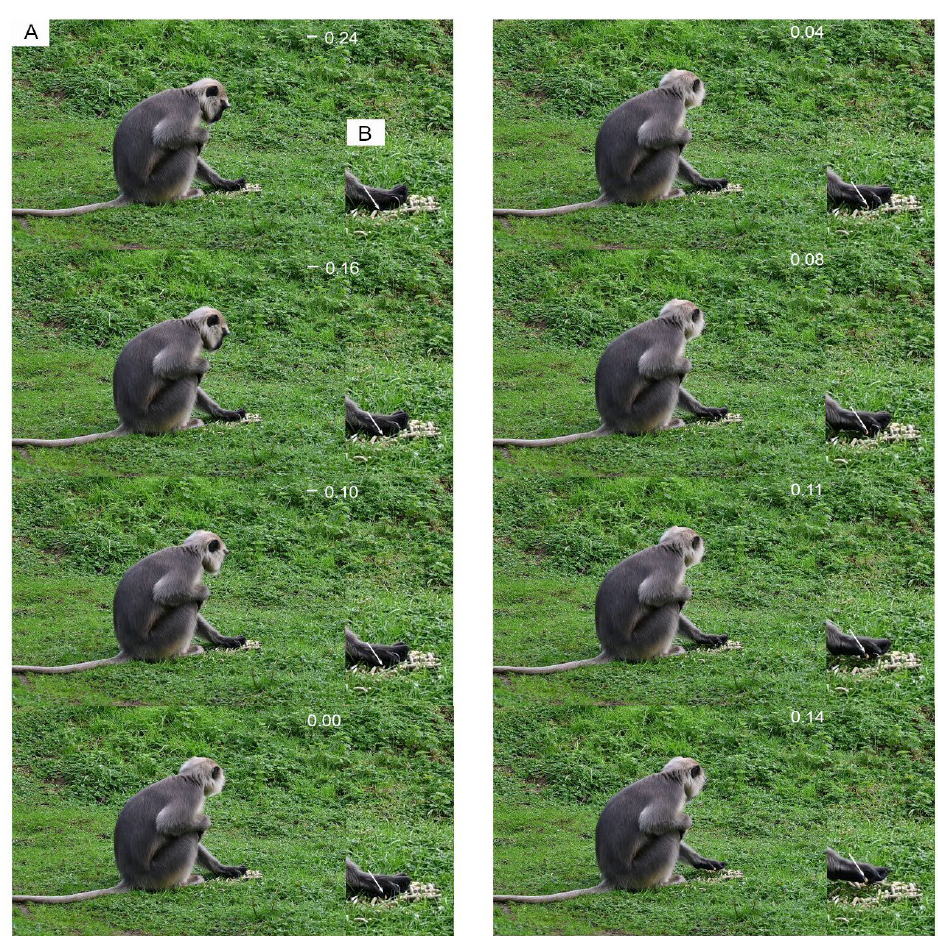
Figure 9. Typical non-rhythmic movement for single-handed food grasping in Semnopithecus entellus. ( A ) View the animal posture during grasping. ( B ) Close-up view of the hand showing the grasping movements of the digits. At time: − 0.24 s, the animal examines the food source, and then scans the environment during the grasping sequence (Time: − 0.16 to 0.14 s). The white arrow indicates the piece of food selected by the animal. Time 0.00 corresponds to the grasping of the food by the digits. The animal is filmed at 100 Hz.